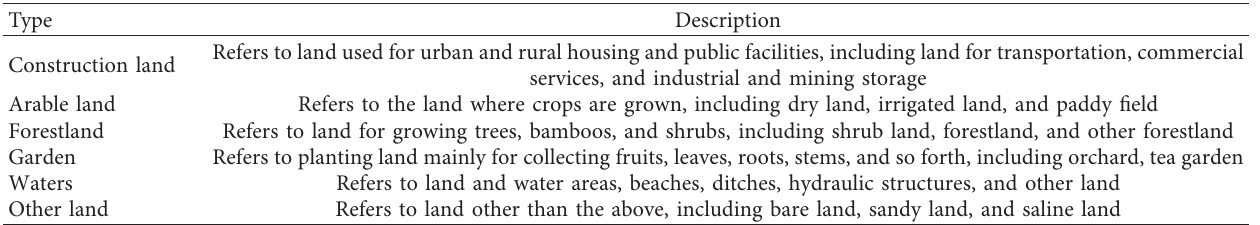
Table 2: Description of land use classification.